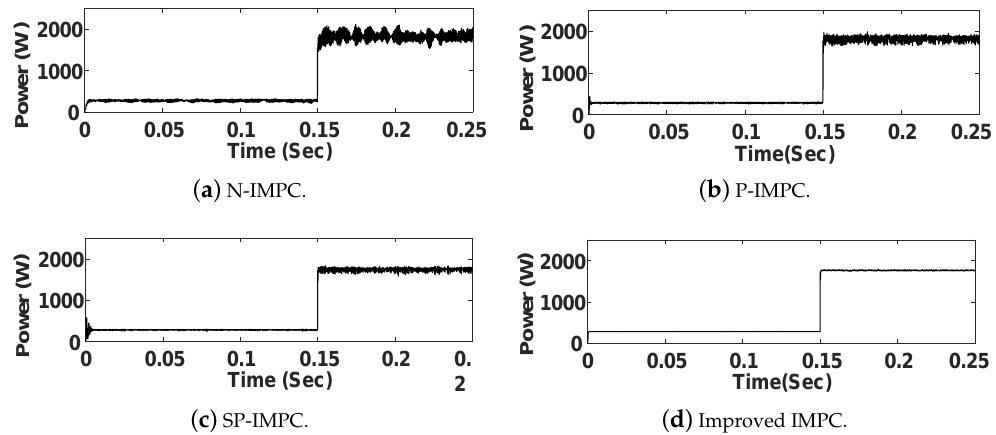
Figure 19. Dynamic response of active power using frequency control methodologies with improved CF (IMPC). ( a ) Notch filter control using the improved CF (N-IMPC), where the power deviation is less than the conventional CF (N-CMPC) with 1.47 % average; ( b ) periodic control using the improved CF (P-IMPC), where the power deviation is less than the conventional (P-CMPC) with 5.36 % average; ( c ) simple penalization control using the improved CF (SP-IMPC), where the power deviation is less than the conventional CF (SP-CMPC) with 1.39 % average; and ( d ) improved